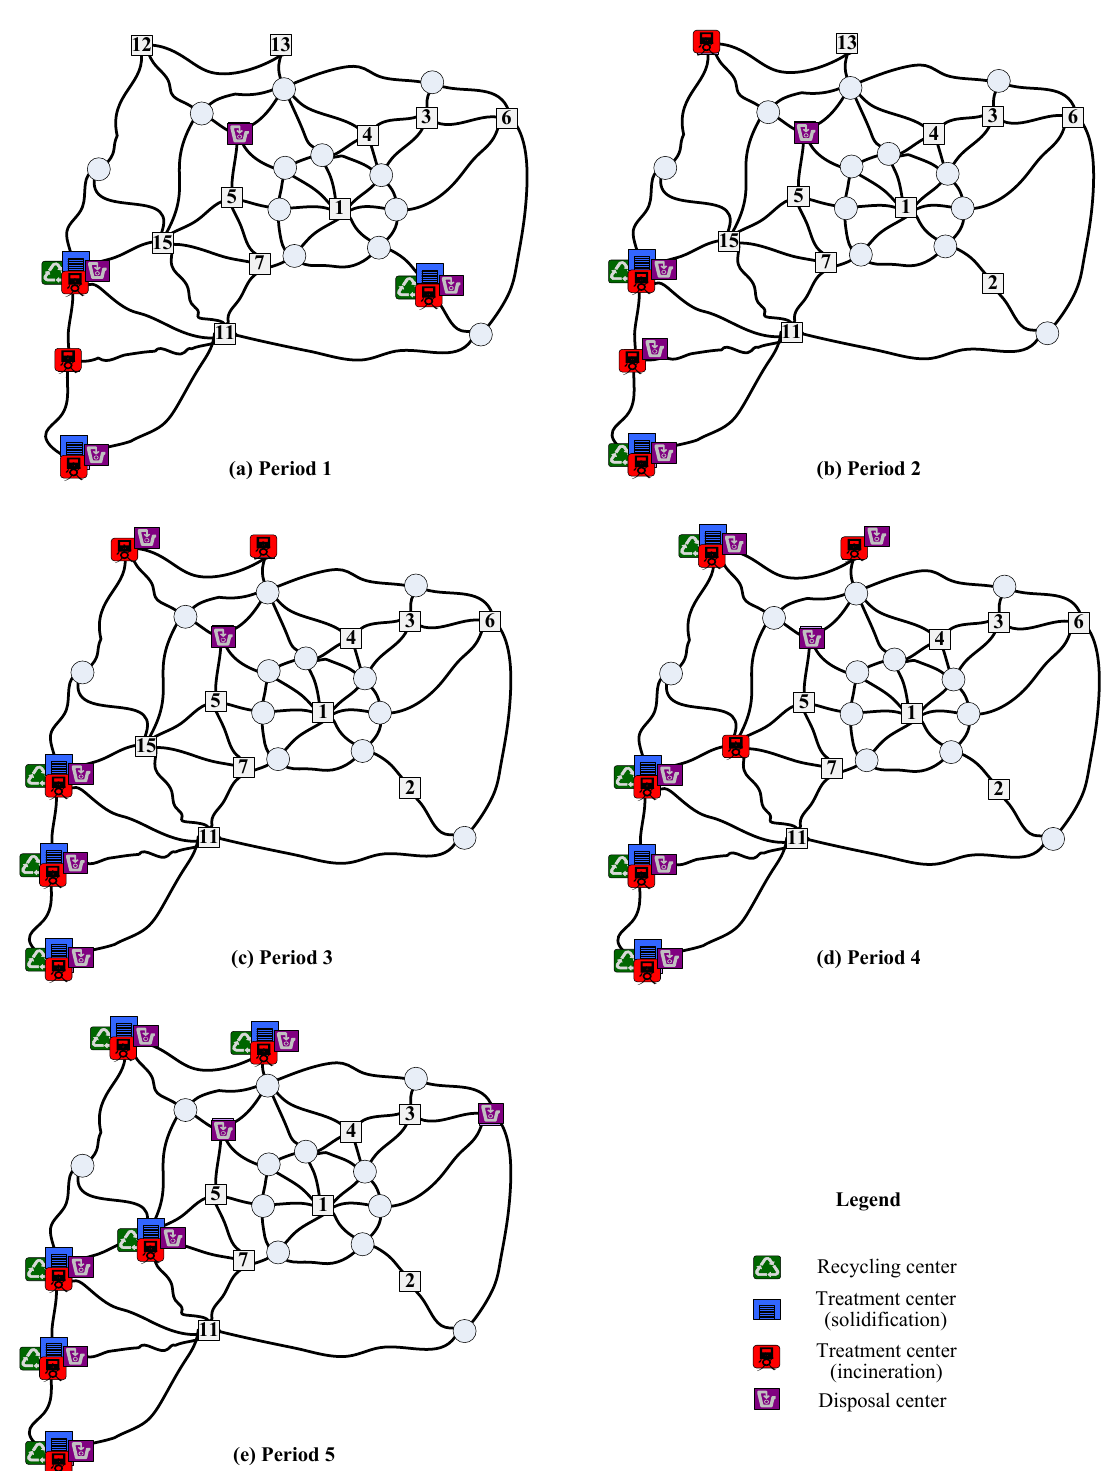
Figure 8. Location in non-dominated solution 3 (minimal total